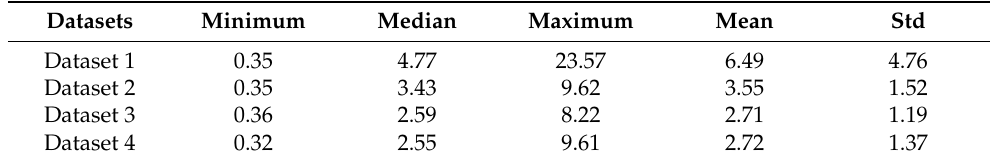
Figure 3. The original data of the four wind speed datasets. Table 2. The statistical information of the four wind speed Table 2. The statistical information of the four wind speed datasets.